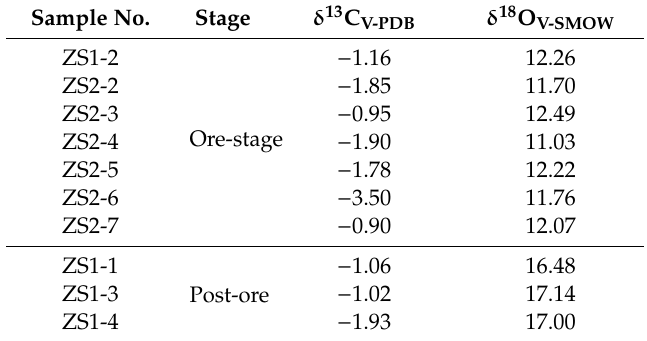
Table 3. C-O isotopic compositions of calcites from the Zhesang gold deposit (% (cid:24) ). Sample No.